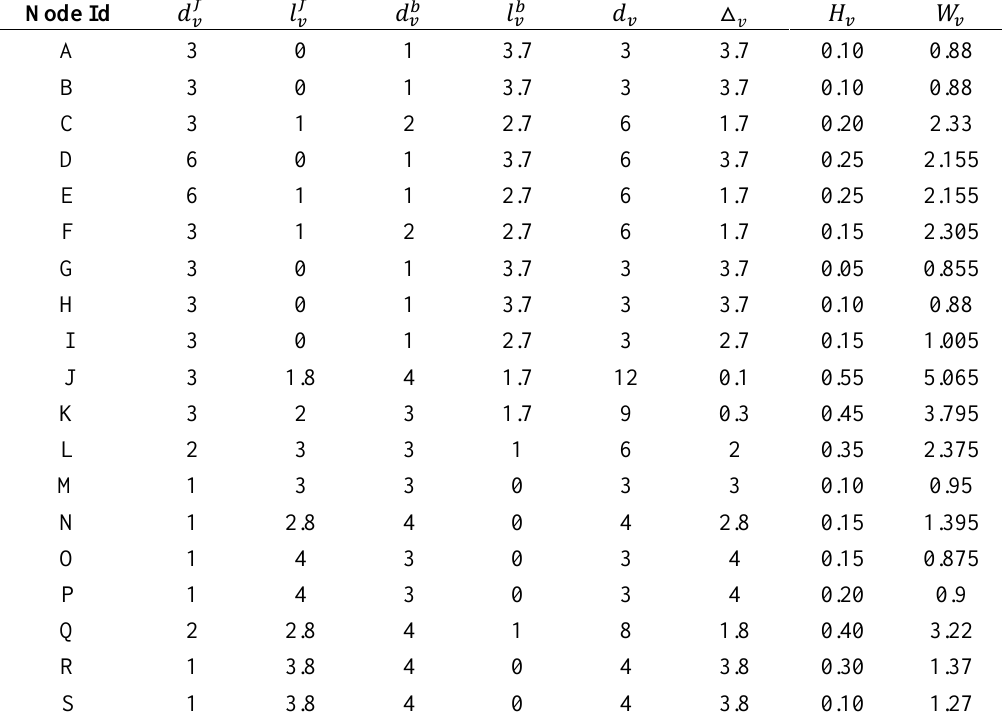
Table 3. Execution of path splitting